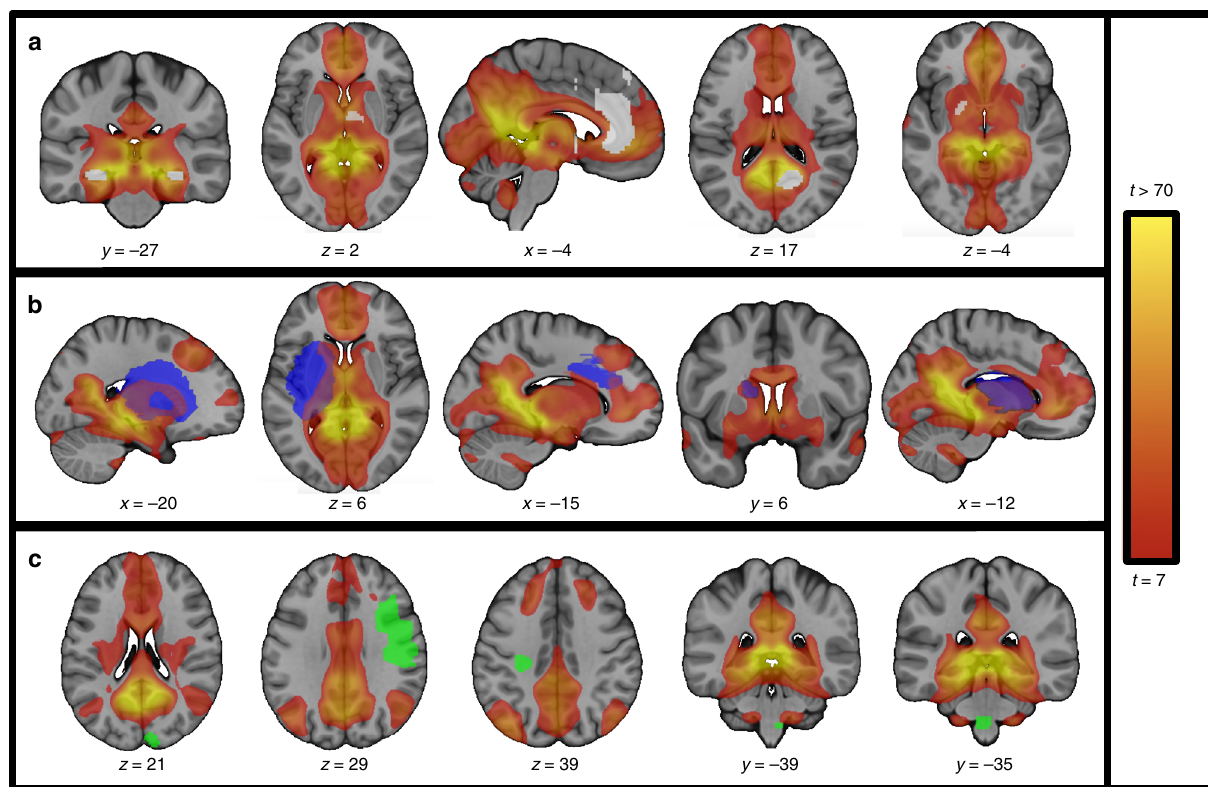
Fig. 4 Validation of our human memory circuit in independent lesion cohorts. Functional connectivity with the subiculum-retrosplenial continuum (see Fig. 3d) de fi nes a human memory network that by de fi nition encompasses 51/53 lesion locations causing amnesia ( a , lesion locations shown in white). Intersection between lesion location and this network was associated with memory scores in an independent lesion dataset ( n = 97), including the fi ve patients with the worst verbal memory scores ( b , lesion locations shown in purple) and the fi ve patients with the best verbal memory scores ( c , lesion locations shown in green)